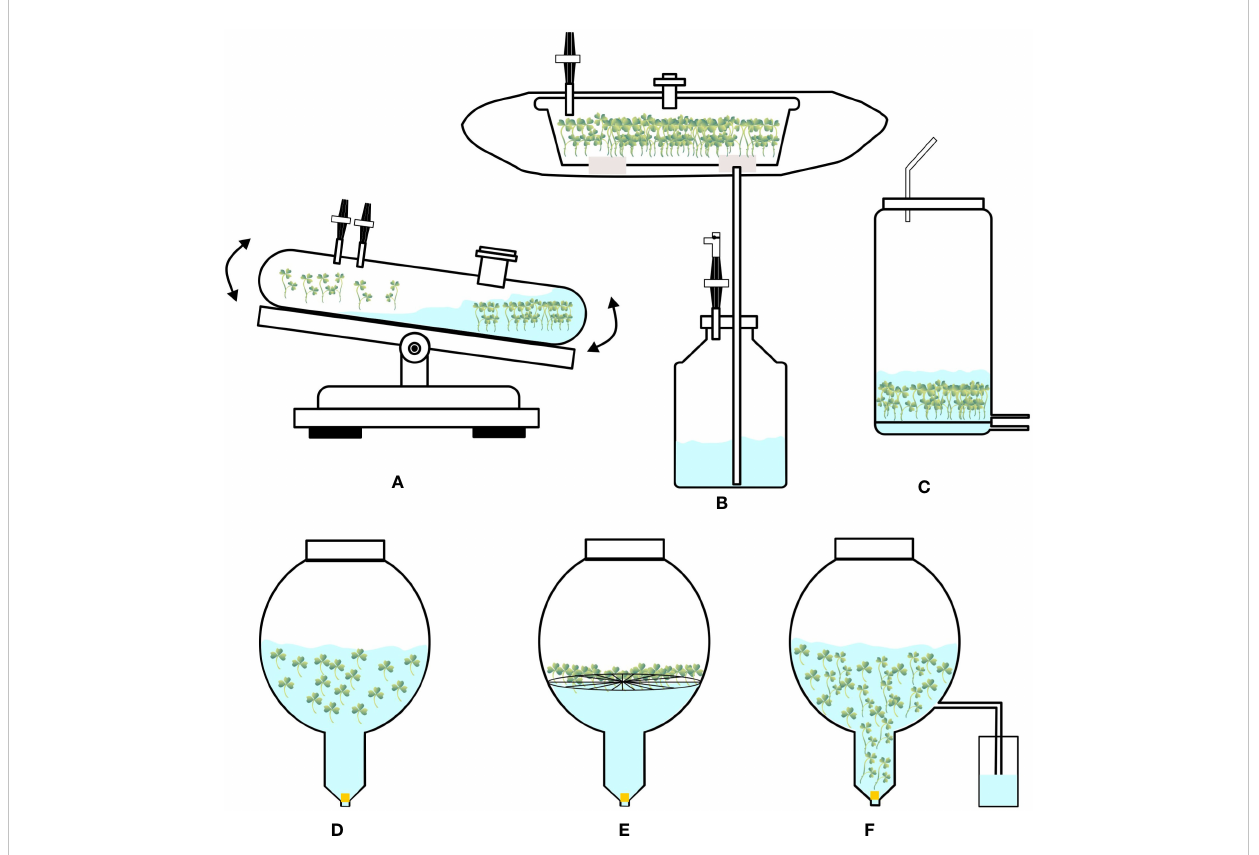
FIGURE 2 Con fi gurations of (A) Wave bioreactor, (B) Box-in-bag bioreactor, (C) Vertical-column bioreactor, (D) Balloon-type bubble bioreactor, (E) Balloon- type bubble bioreactor operating on raft method, (F) Balloon-type bubble bioreactor operating on ebb and fl ood